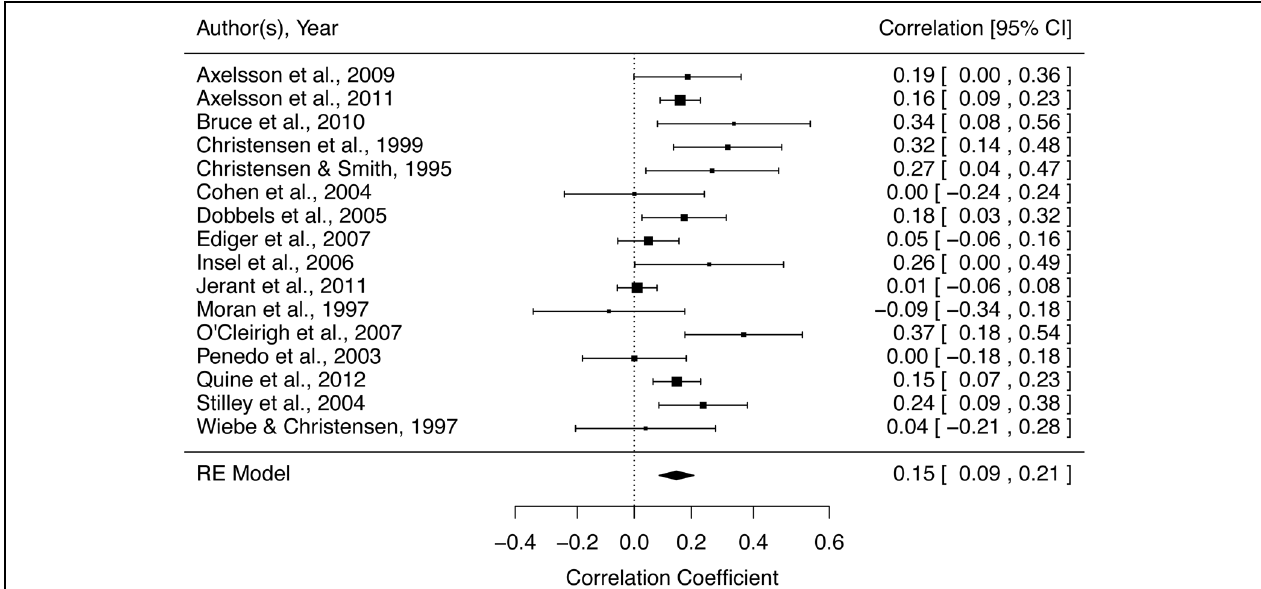
FIGURE 4 | Forest plot of example data. Summary of example data investigating the relationship between conscientiousness and medication adherence. Each study included in the meta-analysis is represented by a point estimate, which is bounded by a 95% CI. The summary effect size is displayed as a polygon at the bottom of the plot, with the width of the polygon representing the 95%